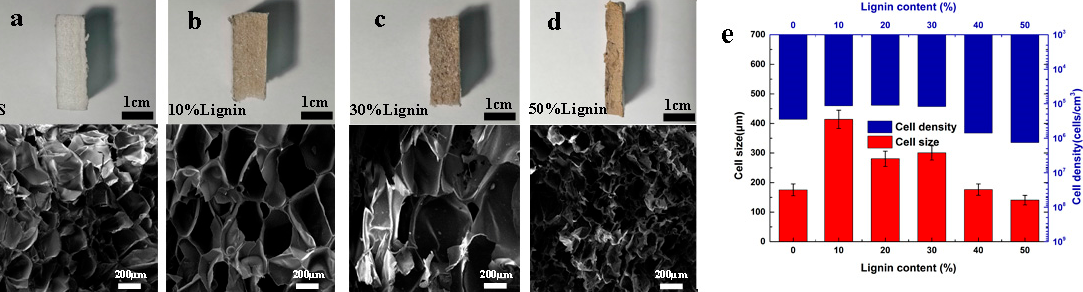
Figure 2. The cross-section view of extruded PS/lignin composite foams and representative cell morphology observed by scanning electron microscope (SEM) (the magnification ratio was 100 times). ( a ) pure PS; ( b ) 10 wt% lignin; ( c ) 30 wt% lignin; ( d ) 50 wt% lignin; ( e ) the cell size and cell density of PS/lignin composite foams.